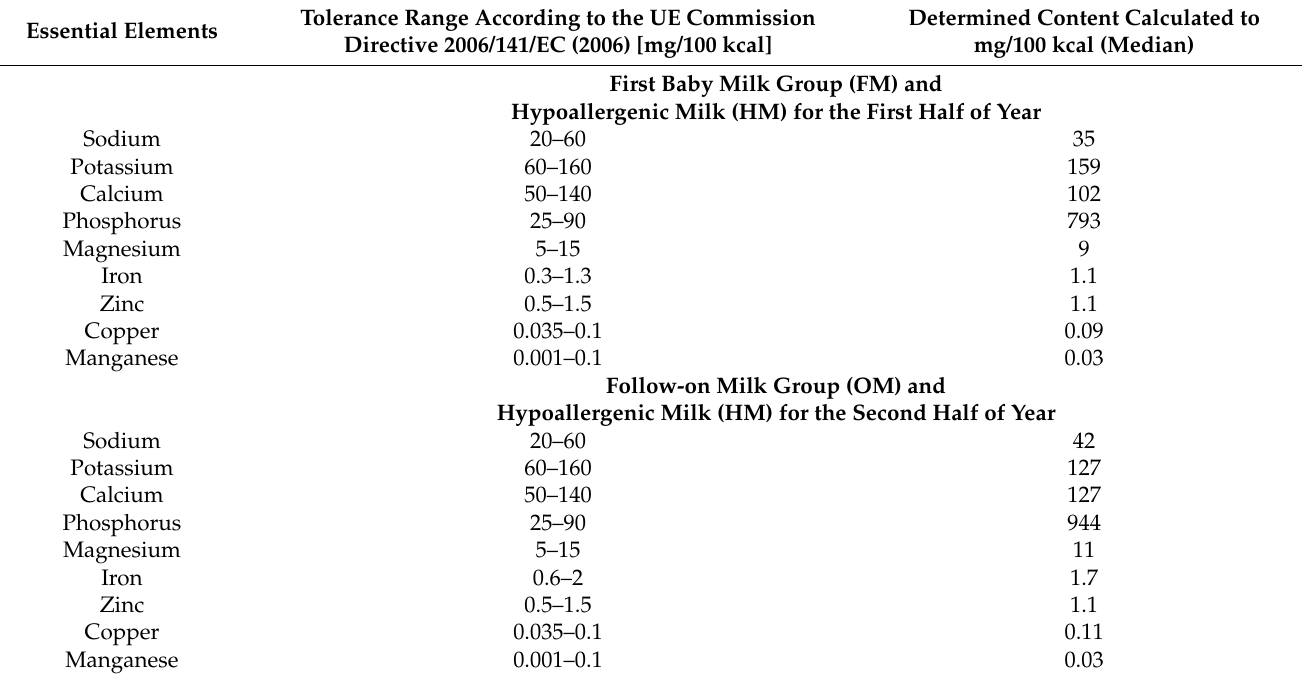
Table 2. The comparison of obtained data with tolerance range established in the European Union standards according to EU Commission Directive 2006/141/EC (2006)